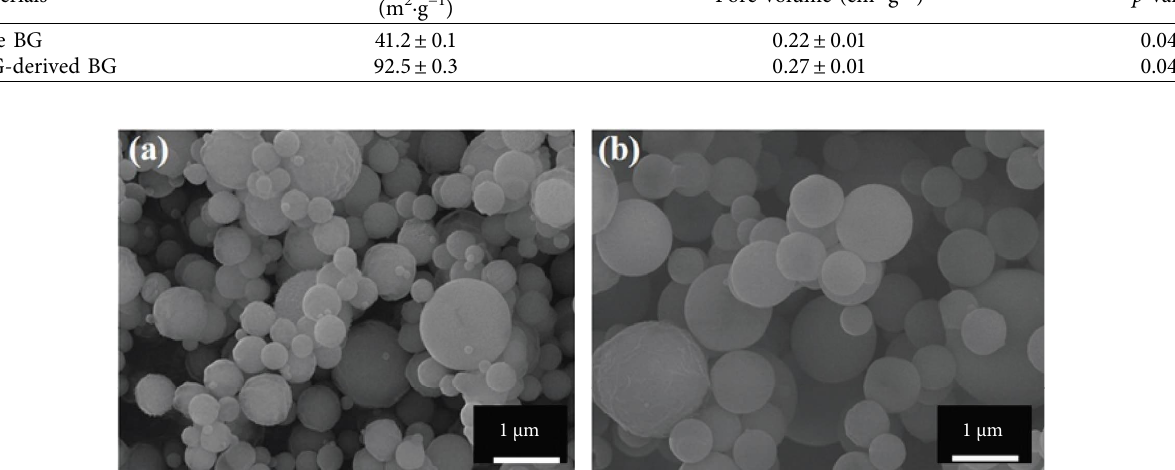
Table 1: Te specifc surface area and pore volume comparison of pure and PEG-derived BG powders. Materials